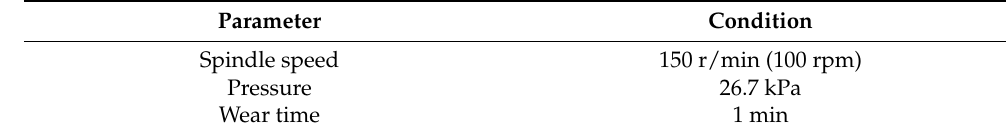
Table 2. Wear test parameters.